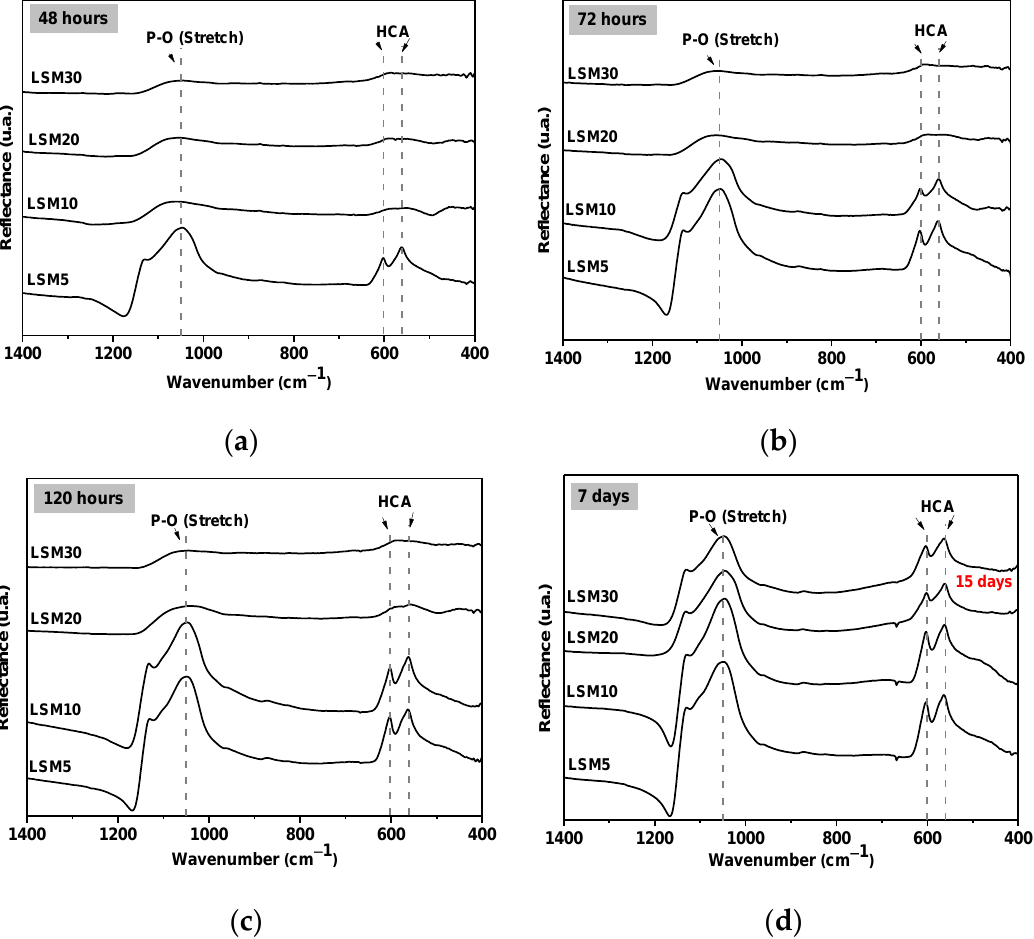
Figure 16. Infrared spectroscopy (FTIR) for the composite samples after SBF soaking (HCA peaks highlights by black arrows). ( a ) 48 hours, ( b ) 72 hours, ( c ) 120 hours, ( d ) 7 days with exception of LSM30 by 15 days.